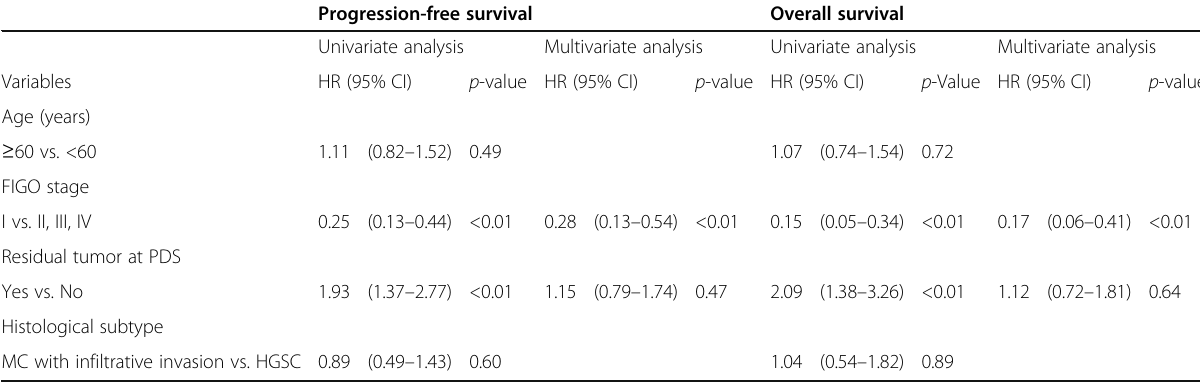
Table 3 Survival analysis for cases of mucinous carcinoma with infiltrative invasion and high-grade serous carcinoma